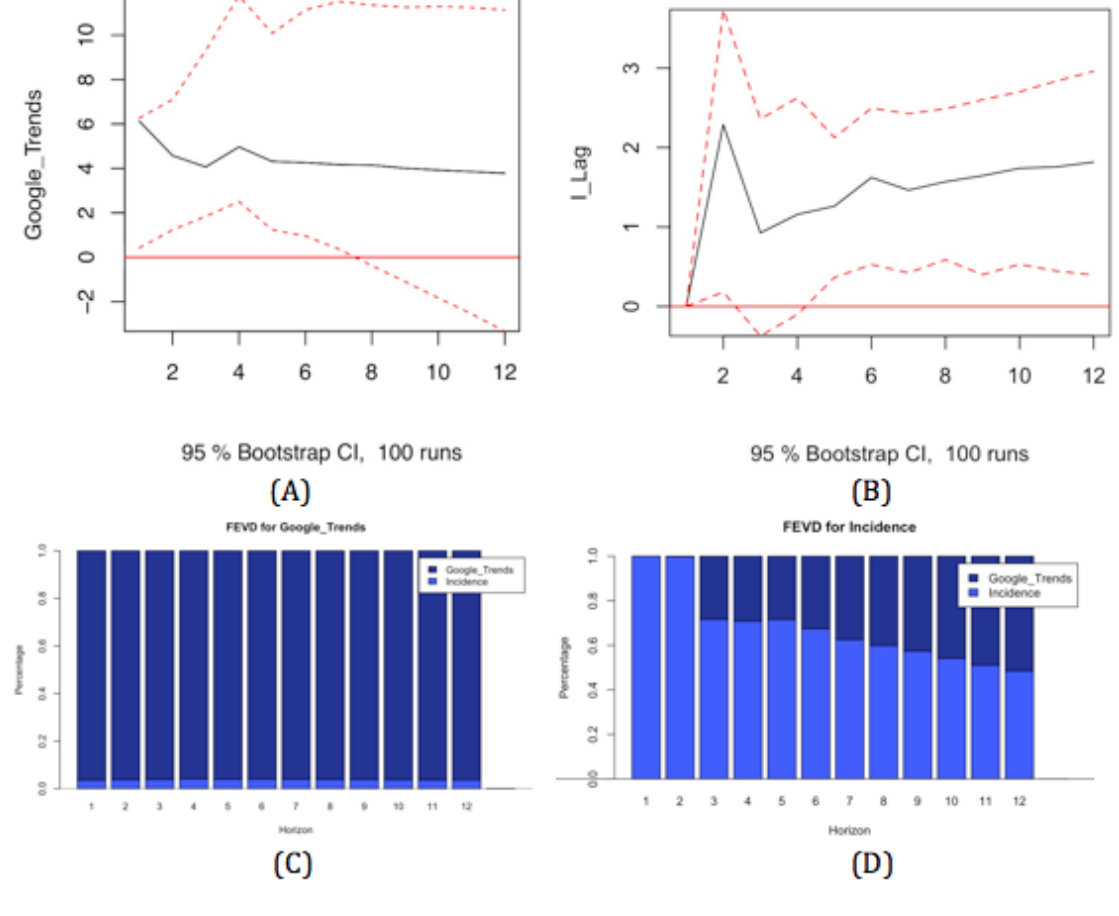
Figure 3. Impulse response function of (A) dengue data from Google Trends with respect to reported cases and (B) reported cases with respect